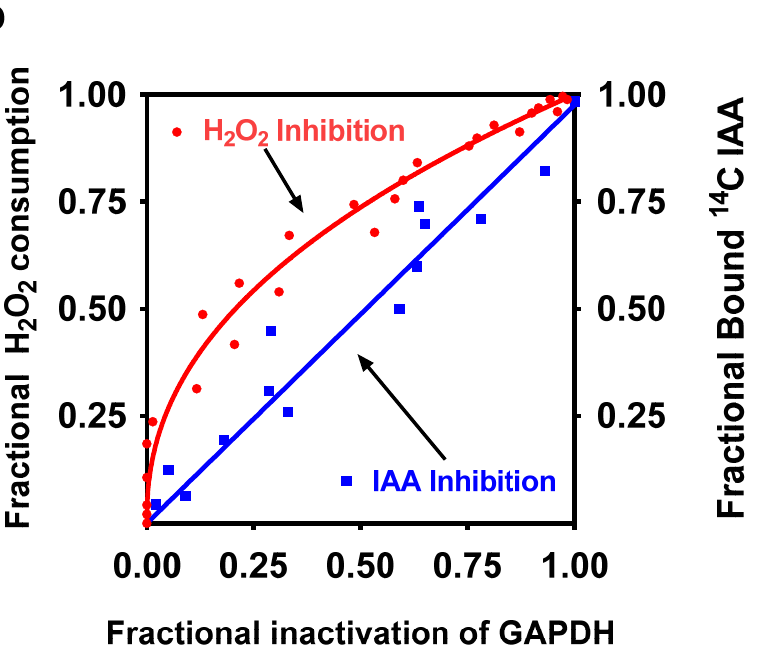
Figure 1. ( A – D ) Kinetics and stoichiometry of cysteine residues oxidized by H 2 O 2 . ( A ) Corre- lation of loss of p − GAPDH activity and quenching of Racker absorption by the selective C c (SH) oxidizing agent IOB and H 2 O 2 (in the absence of reducing agents) at 14 ◦ C. The similarity of the time − dependence of inactivation by IOB is consistent with H 2 O 2 oxidation of C c (SH) to C c (SOH) inactivating the enzyme. ( B ) pH dependence of initial Racker absorption and rate of Racker absorp- tion quenching is increased by rising pH following the addition of excess H 2 O 2 to p − GAPDH at 14 ◦ C. Fitted rate constants ( k ) and extrapolated initial absorption intensities (y 0 ) were calculated from mono − exponential decays curve − fits. ( C ) Loss and recovery of DTNB titratable cysteines/mol in native and H 2 O 2 − oxidized p , human ( h ) , and yeast ( y ) − GAPDH (Mean ± SD, n = 4). ( D ) The fractional total consumption of H 2 O 2 ( y , left ordinate) and fractional total binding of IAA ( y , right ordinate) plotted against the fractional inactivation of GAPDH subunit enzyme activity ( x ). The data were fitted to the power function, y α = x β . The ratio of exponents determines the stoichiometric ratio of reactants from start to finish of the inactivation process.